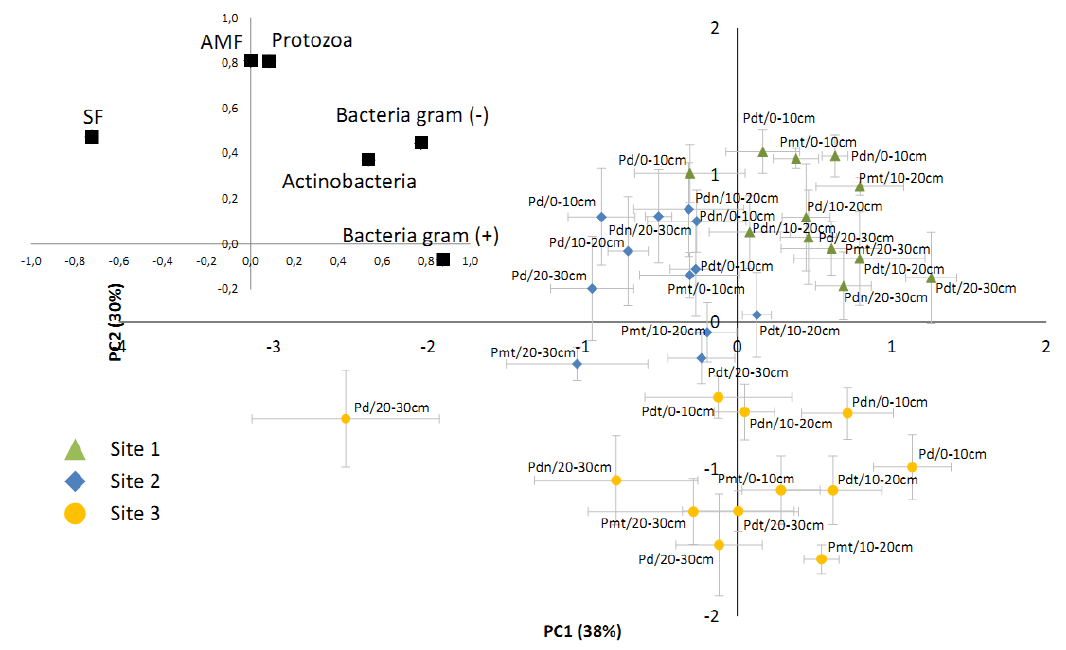
Figure 5. Principal Component Analysis (PCA) diagram of whole-cell fatty acids profiles of microbial communities in soil of three sites, four poplar genotypes (Pd— Populus deltoides ; Pdn— P. deltoides × P. nigra ; Pdt— P. deltoides × P. trichocarpa ; Pmt— P. maximowiczii × P. trichocarpa ) and three depths (0–10 cm; 10–20 cm; 20–30 cm).